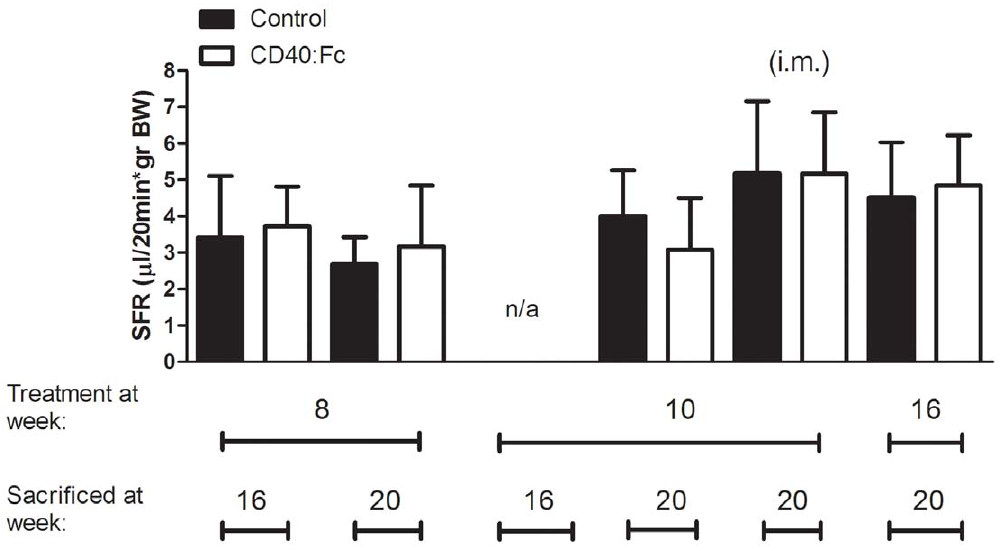
Figure 5. Stimulated salivary flow of CD40:Fc treated and control non-obese diabetic mice. At the indicated age, mice were anesthetized and given pilocarpine to stimulate salivary flow and saliva was collected. Salivary flows corrected for body weight (SFR) of the different treatment groups are shown as a mean + standard deviation (SD; n=8–10 per group, i.m.=intramuscular, n/a=not available).